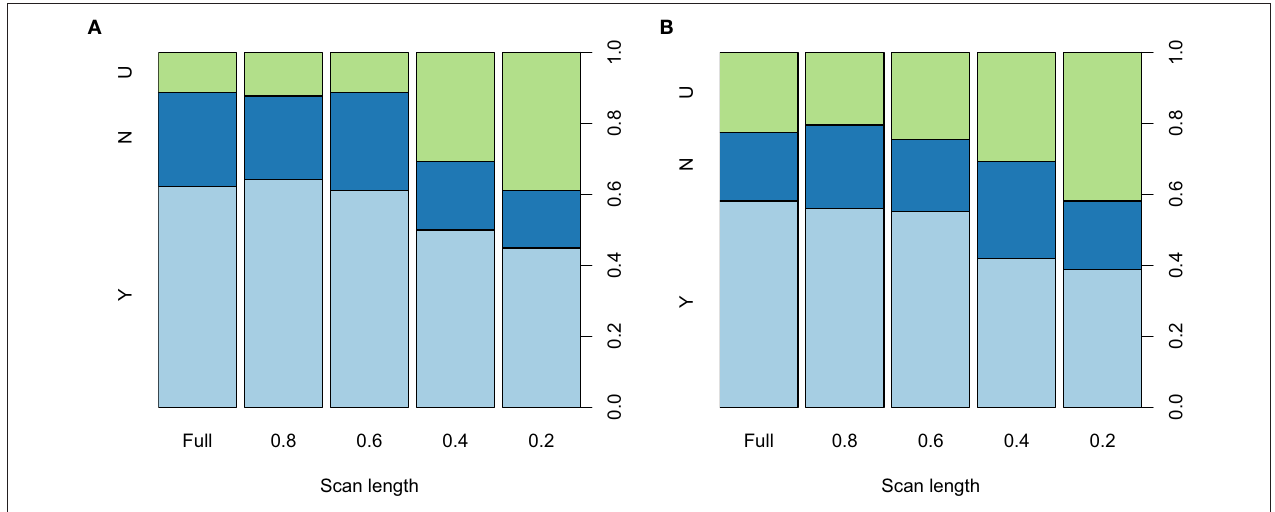
FIGURE 5 | Spine plots showing the distribution of the qualitative ratings of the BOLD delay maps derived from different resting-state functional MRI scan lengths made by rater 1 (A) and 2 (B) The maps were rated as either showing a perfusion lesion (Y, light blue), not showing a perfusion lesion (N, blue), or being uninterpretable (U, green). Statistically significant differences in interpretability are seen between the full scan and the 0.4 and 0.2 shortened scans. The quantitative results of the binary logistic mixed model investigating the effects of scan length on the interpretability of the BOLD delay maps are shown in Supplementary Table 3